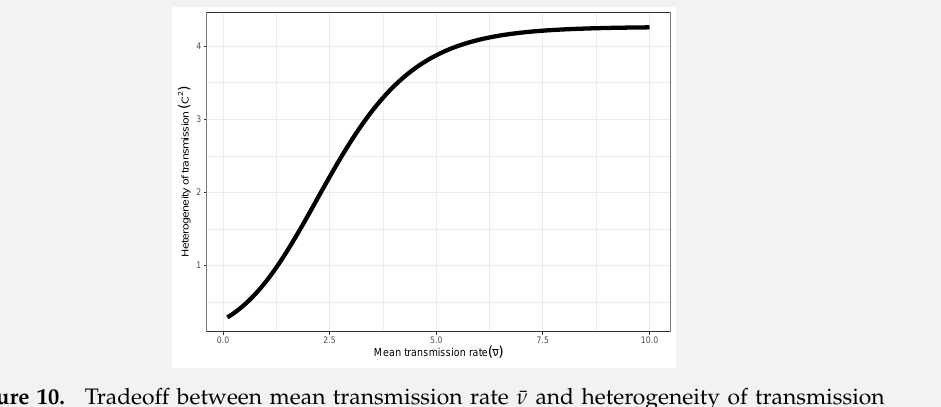
Figure 10. Tradeoff between mean transmission rate ¯ ν and heterogeneity of transmission C 2 . Higher values of heterogeneity C 2 (the squared coefficent of variation of transmission, and thus unitless) leads to lower infection of hosts (see Box 1). The specific function shown here was fit to data from 16 strains of the NPV that infects gypsy moths, Lymantria dispar [79], but the tradeoff itself and general shape of the curve appear to be consistent features of the models used to describe host heterogeneity (Table